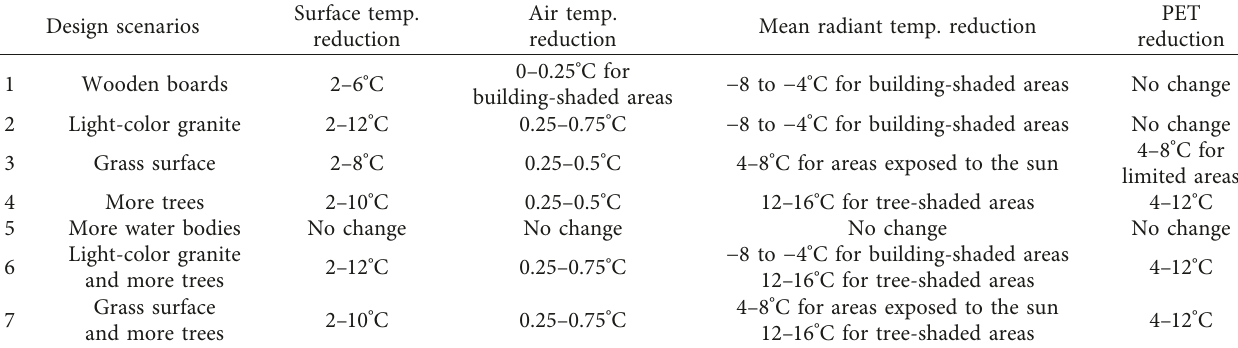
Table 7: Summary of the effect of different design scenarios on urban microclimate and thermal comfort (PET). Surface Design scenarios